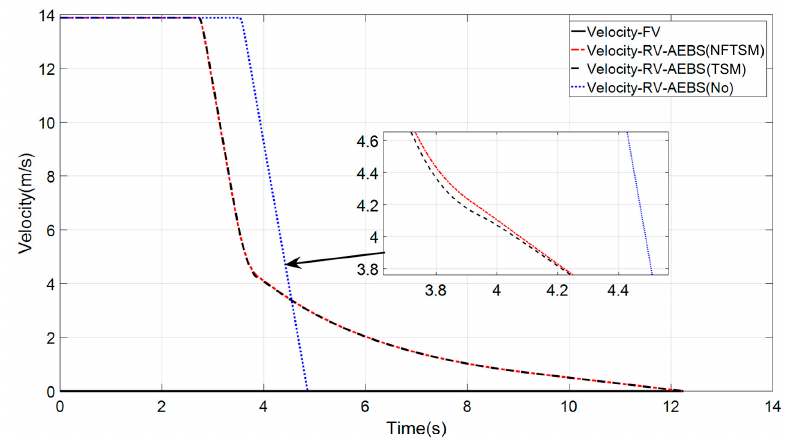
Figure 12. Comparison of relative speed.